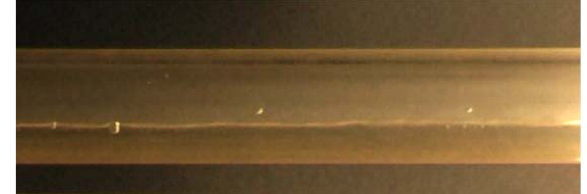
Fig. 5. The first 10 s of filtered signal registered for the described